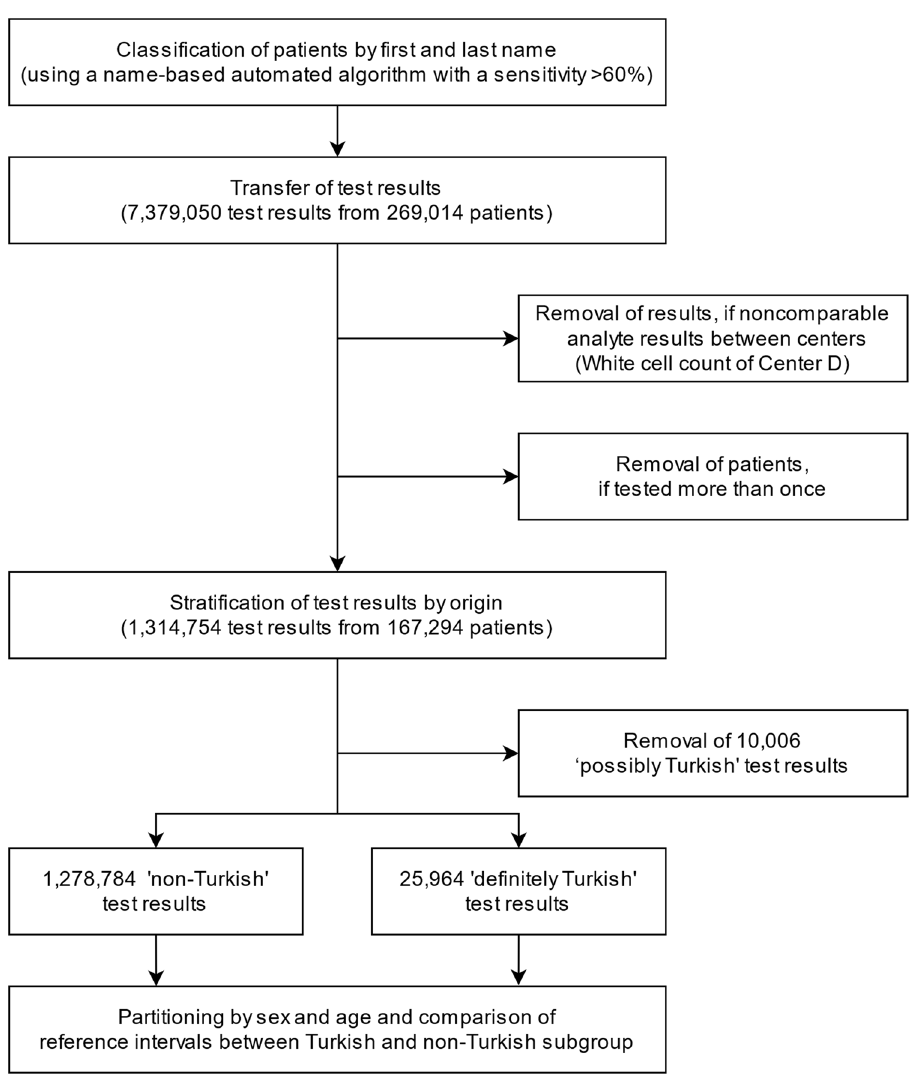
Figure 1. Workflow. Data collection, filtering steps, stratification and calculation of reference and confidence